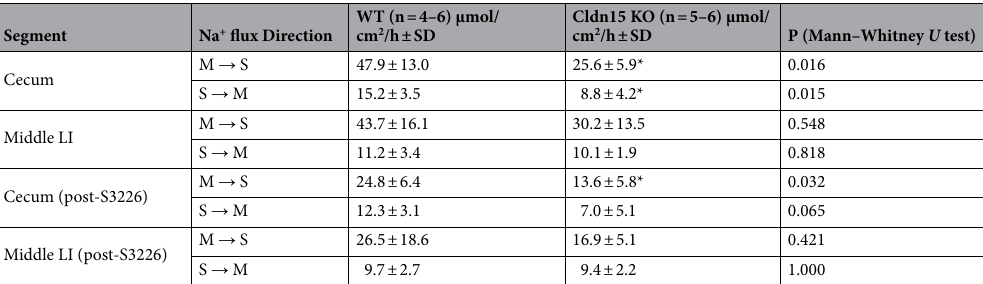
Table 3. Unidirectional Na + flux before and after addition of S3226. Intestinal sheets for the cecum and middle large intestine were prepared by removing the muscle layer and then they were mounted in Ussing chambers. The M → S and S → M unidirectional flux of Na + was measured for each segment. The values in the table represent the average flux ± SD for each segment before and after the addition of the NHE3 inhibitor S3226. The values represent the mean, n = 4–6 for WT and 5–6 for Cldn15 KO (including 1 female). Please see Supplementary Table 6 for data